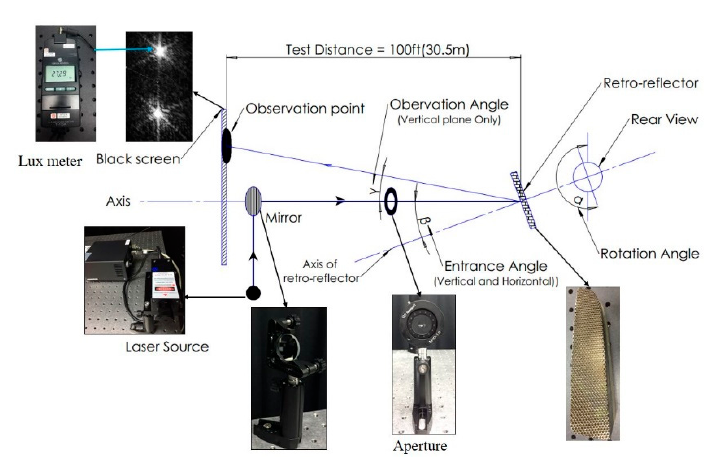
Figure 7. Experimental setup for curved corner-cube retro-reflector (CCCR) testing.